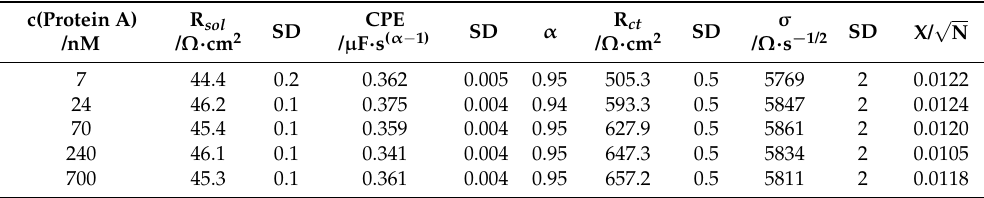
Table 1. Results from the fitting of impedance data to the modified Randles circuit—SD = standard √ deviation, X/ N = error of fitting normalized to the number of data